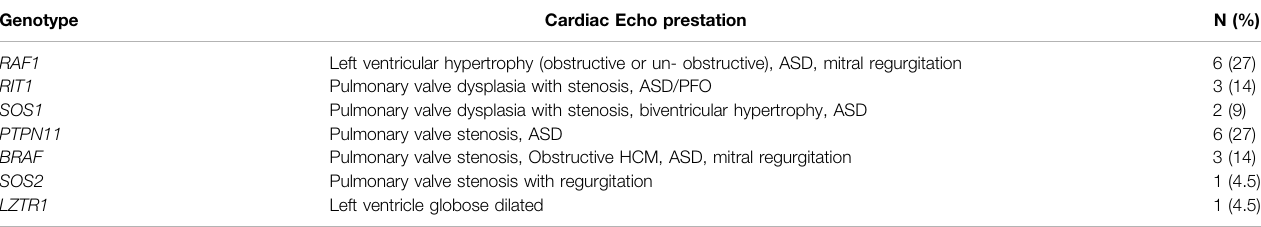
TABLE 2 | Genotype – cardiac phenotype abnormalities in NS patients (N = 22).